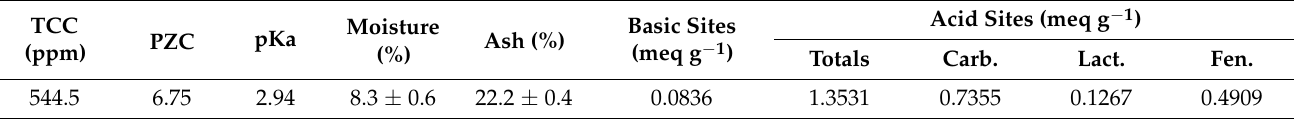
Table 3. Physical and chemical characteristics of Sargassum .